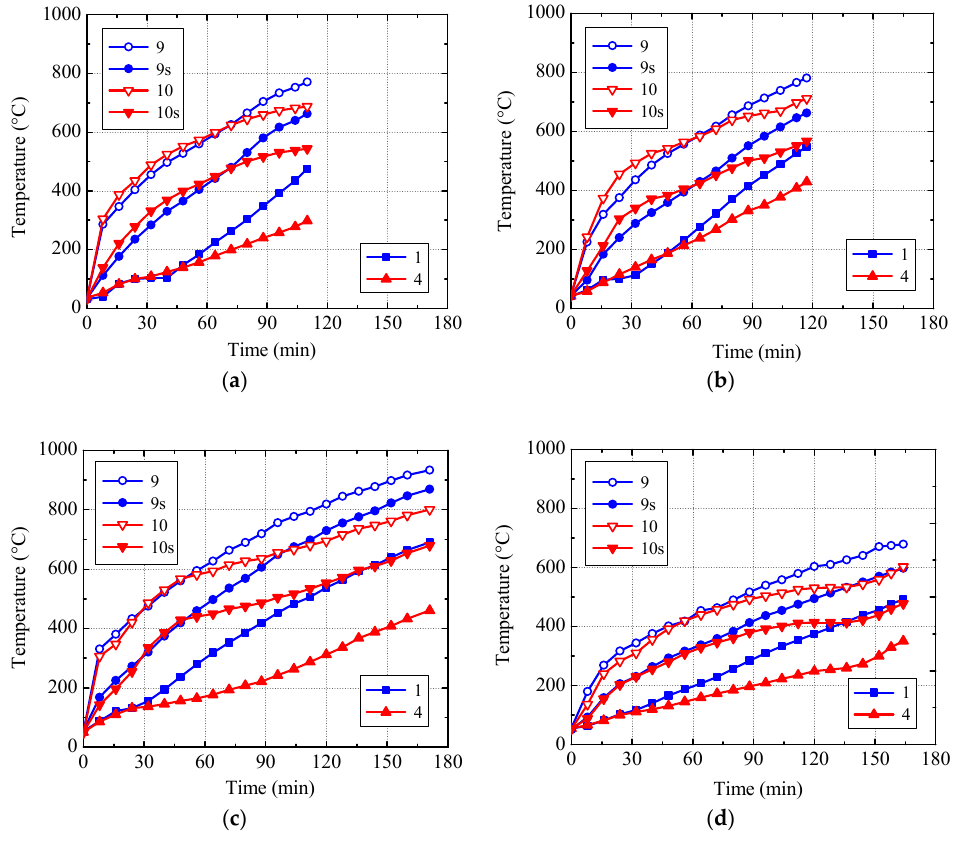
Figure 17. Measured temperature-time curves of Thermocouples 1, 4, 9s, 10s, 9, and 10: ( a ) Specimen B1, ( b ) Specimen B3, ( c ) Specimen B4, and ( d ) Specimen B5.